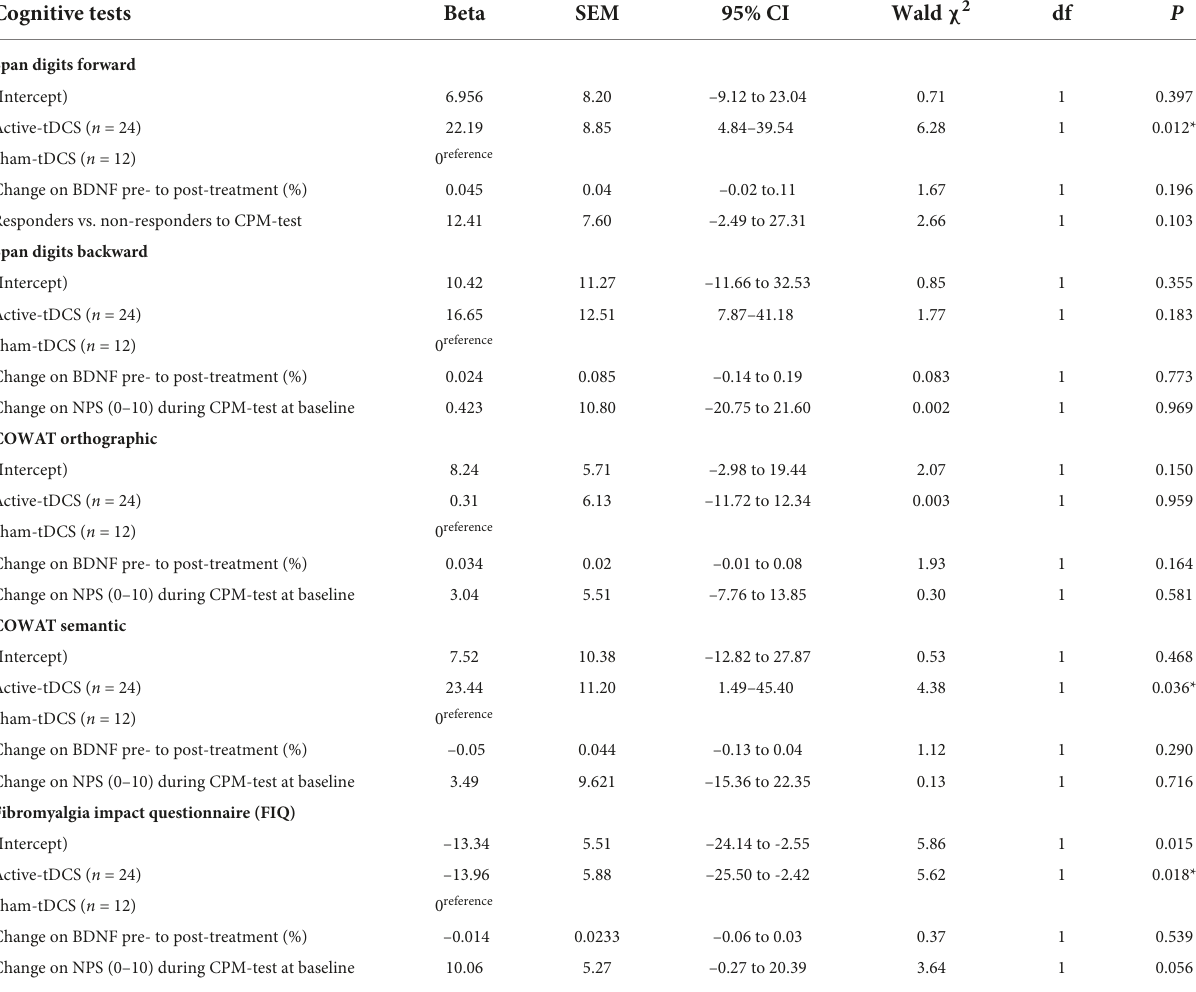
TABLE 4 Effect of treatment on sustained attention, working memory, verbal fluency, phonemic fluency, and quality of